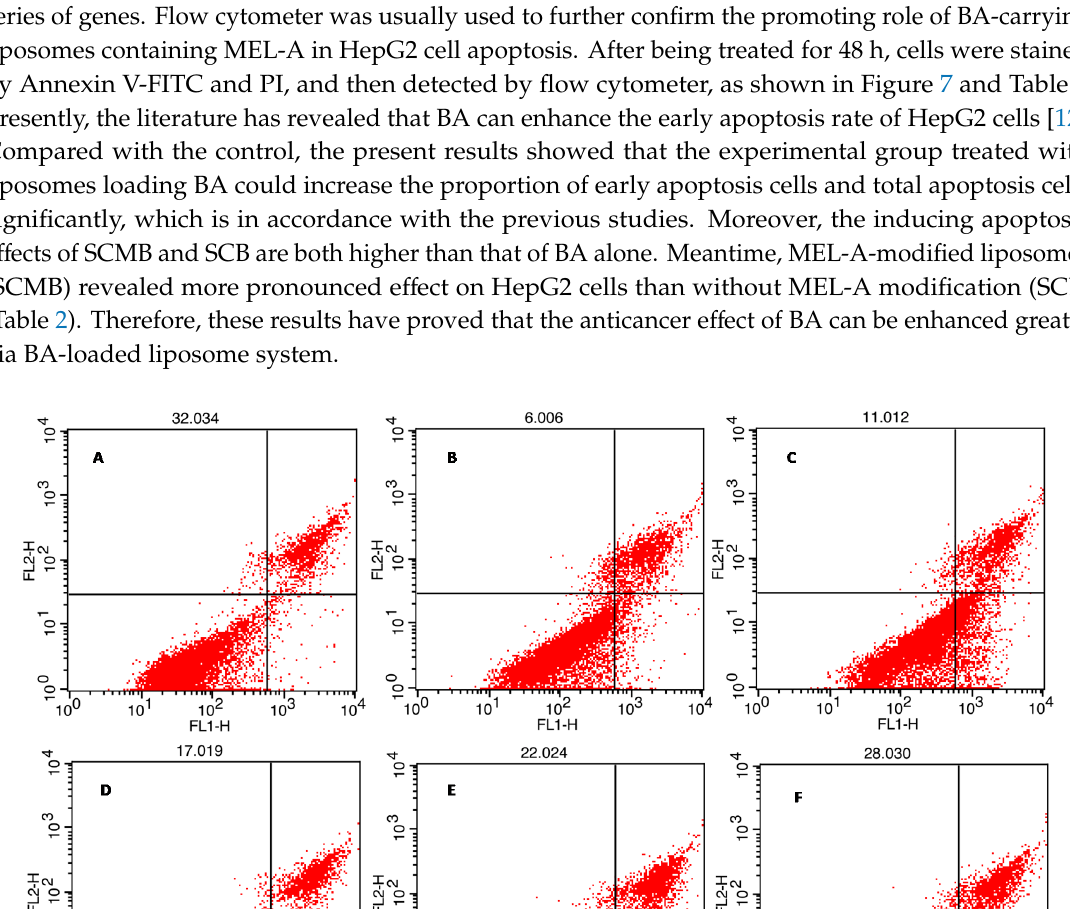
Figure 6. The proliferation changes of HepG2 cells under different treatments for 24 h ( A ) and 48 h ( B ). At each concentration of BA, SC and SCM are prepared under the same condition as well as SCB and SCMB whether adding BA or not.